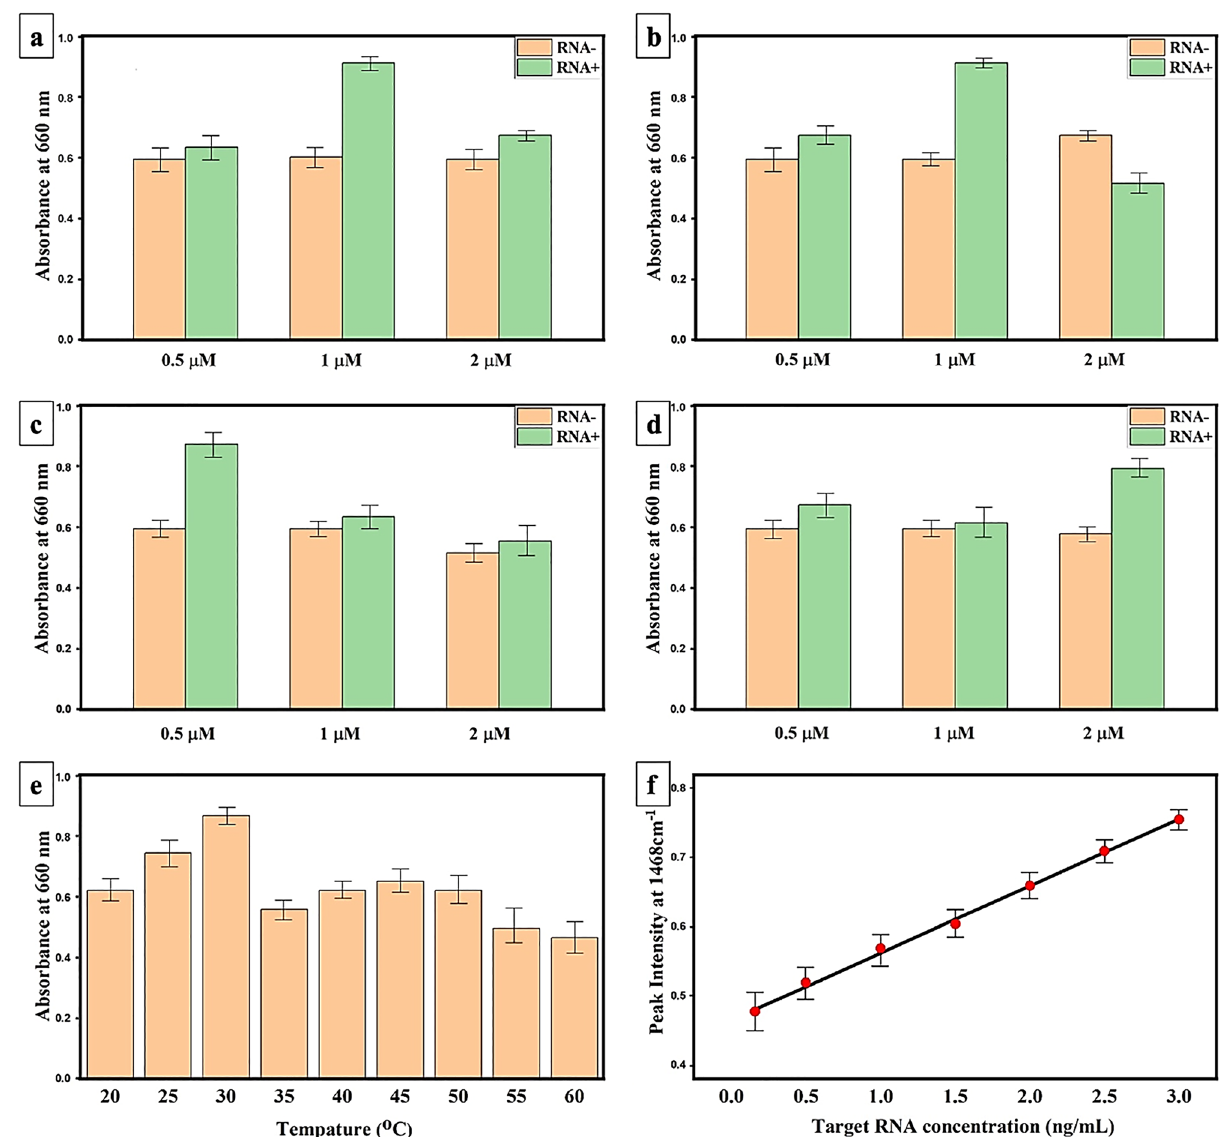
Figure 4. The analytic performance of fabricated biosensor. Absorbance at 660 nm for the AuNPs coated with 0.5, 0.1, and 2 µM of ( a ) SCVP1, ( b ) SCVP2, ( c ) SCVP3, and ( d ) SCVP4 upon the addition of SARS-CoV-2 RNA. ( e ) Effect of temperature on the response of SCVPM gold nanoparticles to the SARS-CoV-2 RNA when RNA concentration kept constant at 1 ng/μL. ( f ) The linear curve of SERS intensity at 1468 cm − 1 in response to target RNA